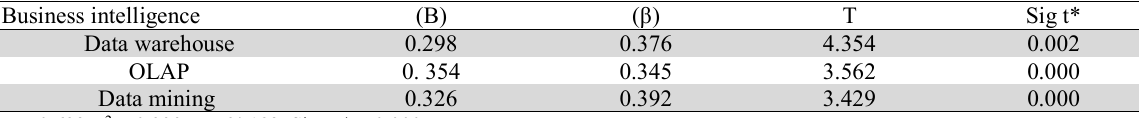
Multiple Regression of the H1 Business intelligence (B) (β) T Sig t* Data warehouse 0.298 Data